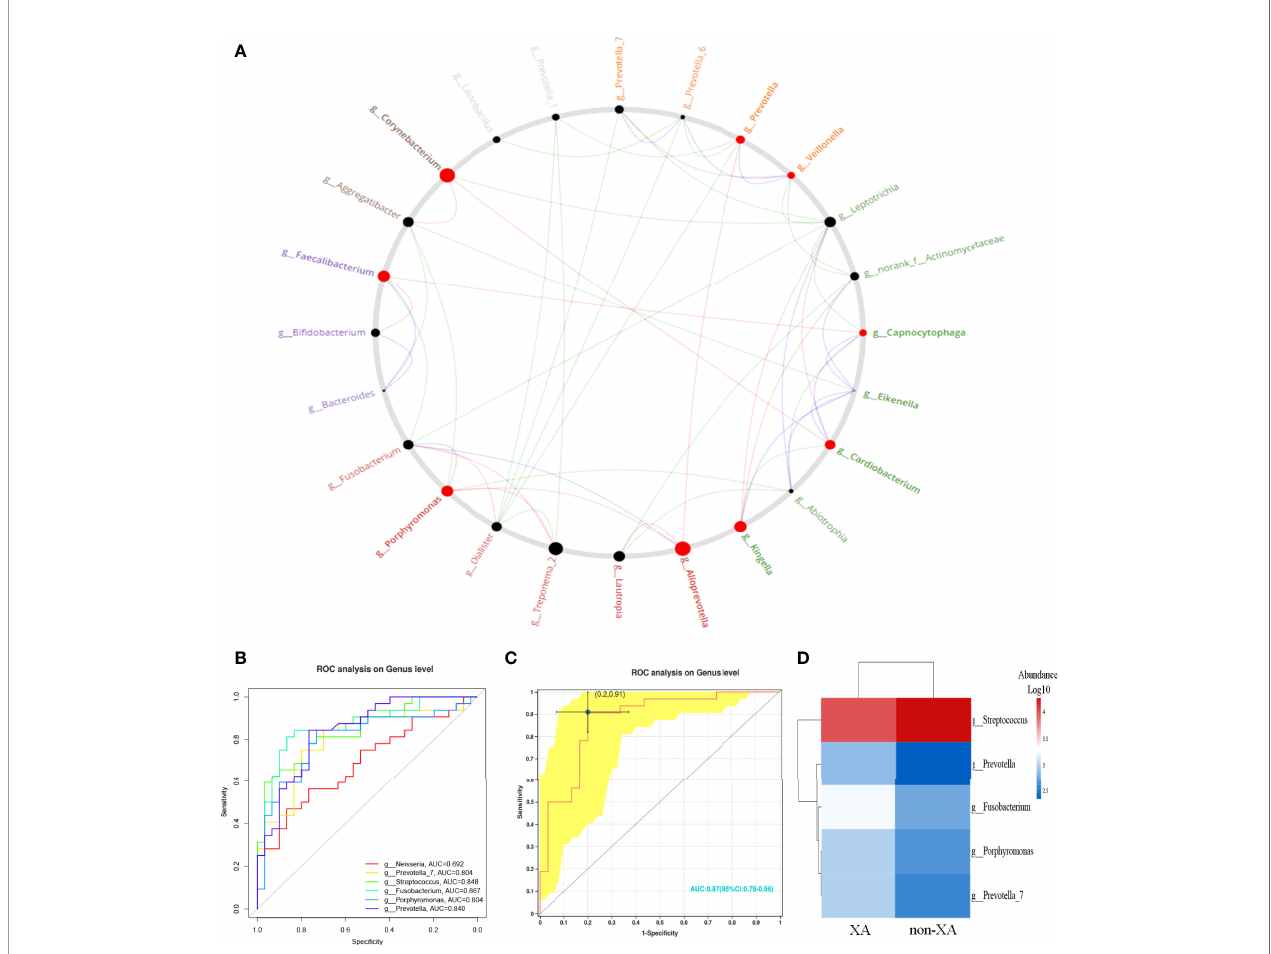
FIGURE 6 | Identi fi cation of driver microbial taxa and prediction for xerostomia. (A) Identi fi cation of oral microbiota driver genera by performing NetShift analysis. The nodes marked in red represented the driver genera, and the size of the nodes represented the NESH score. Oral microbial genera showing pairwise positive correlations only in the non-XA group were shown with green line segments, genera showing positive correlations only in the XA group were shown with red line segments. In addition, blue line segments represented positive correlations between microbial genera among the non-XA and XA groups. (B) Six microbial genera with LDA values greater than four were selected as candidate features and fi ve microbial genera (AUC > 0.7) (C) were further chosen as potential biomarkers. (D) Generated a heatmap based on the selected fi ve predicted features. Hierarchical clustering con fi rmed that the predicted features of the two groups can be separated. The intensity of the squares represented the relative abundance of microbial genera. XA group, xerostomia group; non-XA group, without xerostomia group; LDA, linear discriminant